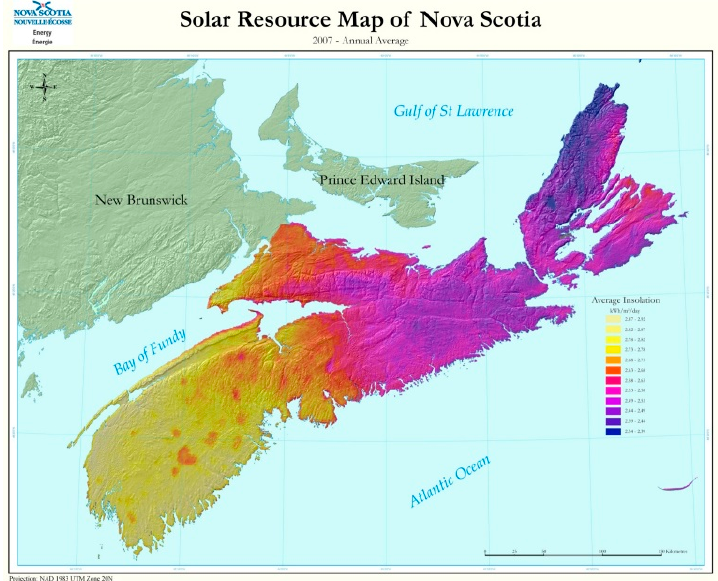
Figure 5. Provincial solar map: Nova Scotia, Canada.